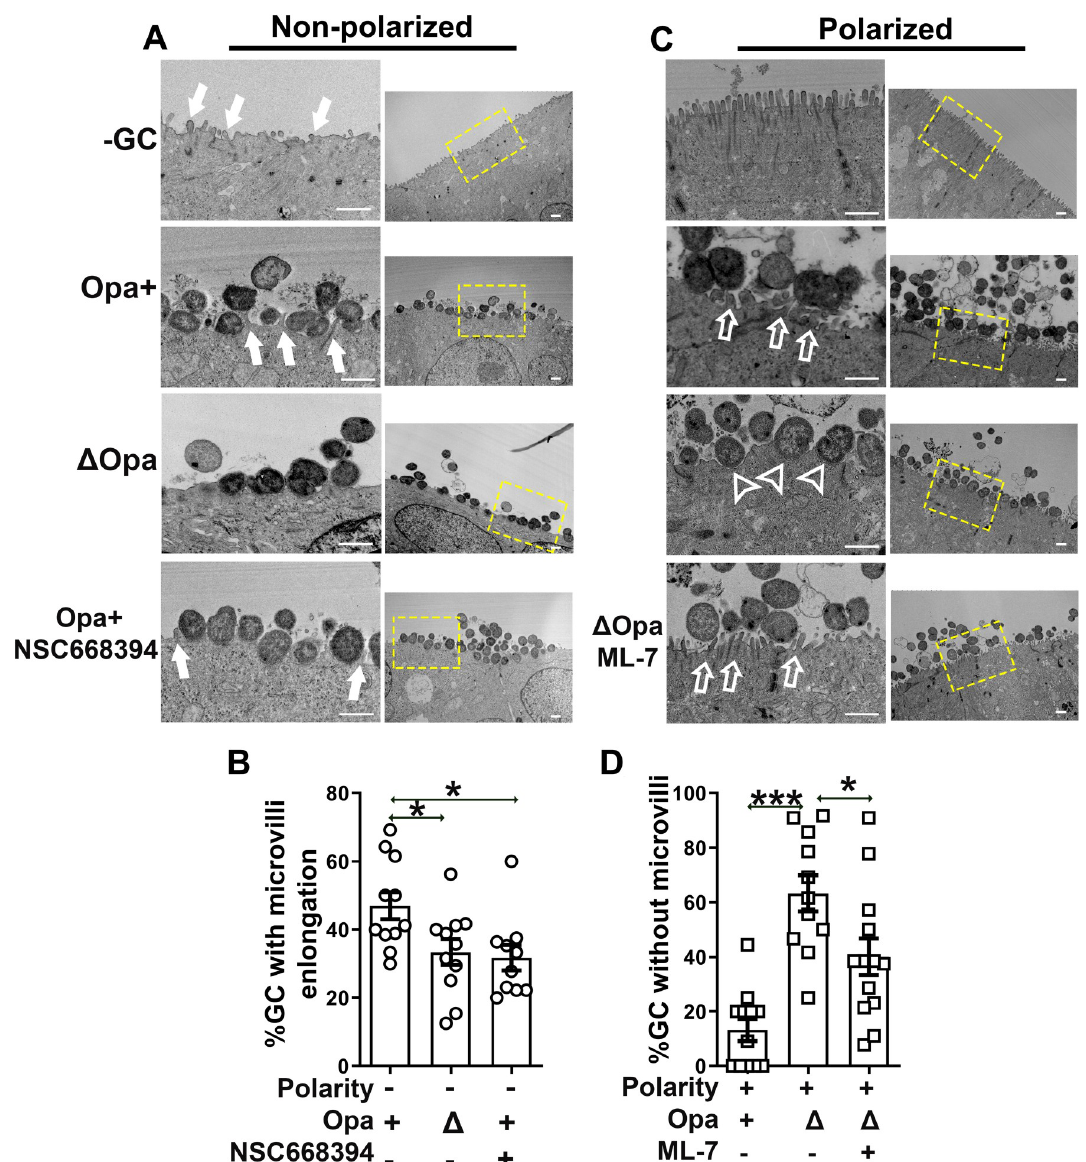
Fig 5. GC differentially remodel the surface morphology of non-polarized and polarized epithelial cells in an ezrin- or NMII- dependent manner. Non-polarized and polarized T84 cells were pre-treated with or without NSC668394 (20 μ M) or ML-7 (10 μ M) and incubated with Pil+Opa+ or Pil+ Δ Opa GC (MOI~50) in the apical chamber for 6 h with or without the inhibitors. Cells were fixed and processed for TEM. (A, C) Shown are representative images with high (left panels) and low (right panels) magnifications. Yellow dash line rectangles highlight the focused area. Solid arrows, GC-associated elongated microvilli. Open arrows, GC contacting bending microvilli. Open arrowheads, no microvilli visible in GC contact sites. (B, D) Membrane morphological changes were quantified by the percentage of GC associating with elongated microvilli in non-polarized epithelial cells (B) and the percentage of GC associating with the plasma membrane of polarized epithelial cells that lost microvilli (D) . Data points represent individual randomly acquired TEM images. Scale bar, 1 μ M. n = 2–3 two to three independent experiments. � p < 0.05; ��� p < 0.001. associating with elongated microvilli from ~47% to ~32% in non-polarized epithelial cells (Figs 5A, 5B and S7A). Conversely, treatment of ML-7 significantly reduced the percentage of GC associating with the epithelial membrane that lost microvilli from ~63% to ~40% in polar- ized epithelial cells (Figs 5C, 5D and S7B). These data suggest that GC adherence induces